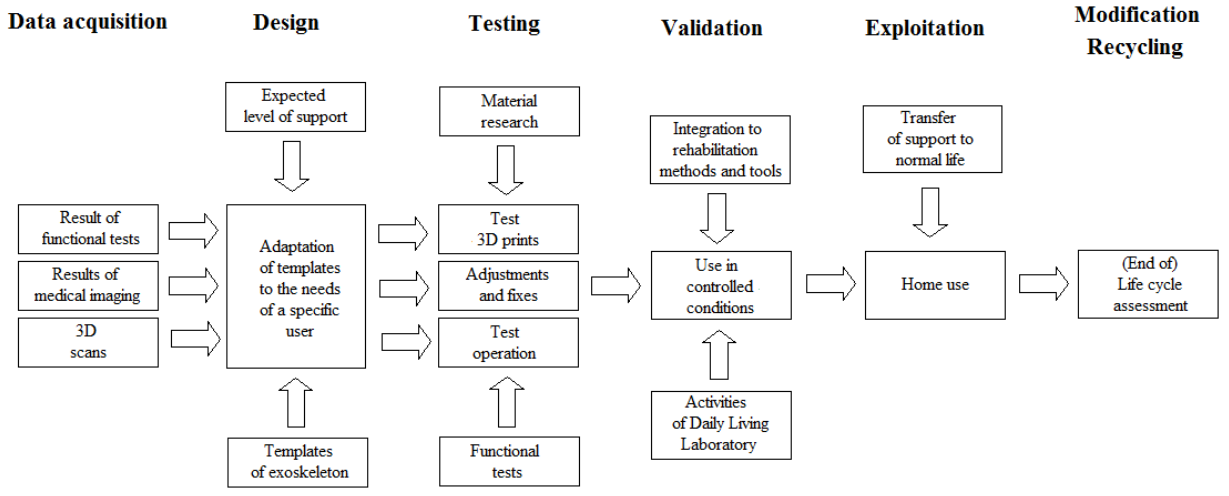
Figure 2. Planning and production cycle of the 3D-printed hand exoskeleton (own version).